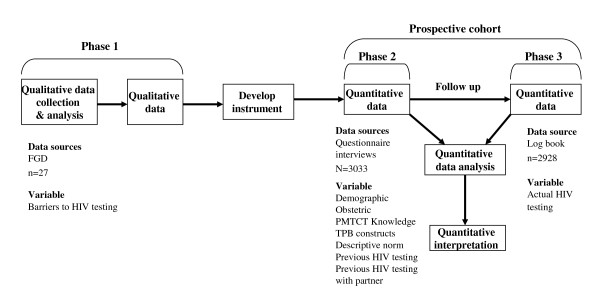
The sequential mixed methods design, the three phases of the study and the study participants in each phase.